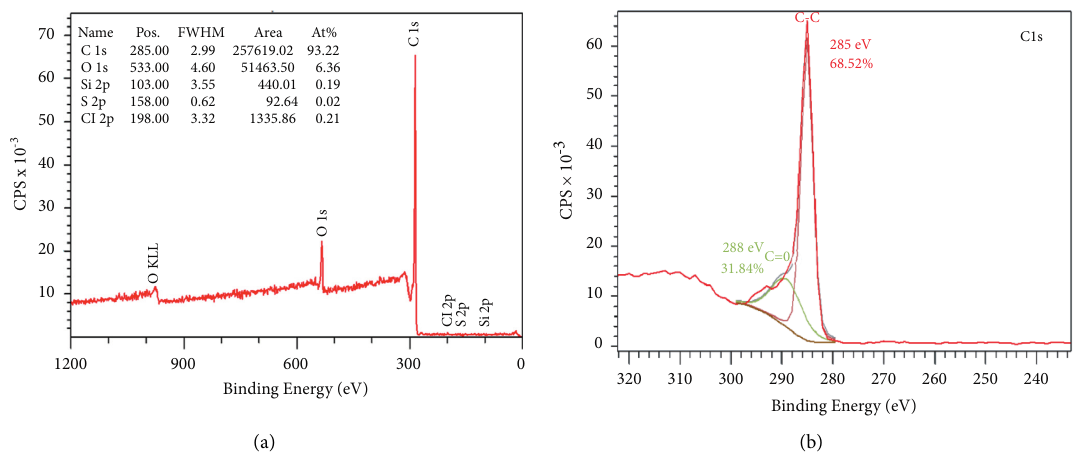
Figure 6: XPS spectra of activated carbon (AC). (a) Survey spectrum. (b) C 1s spectra.